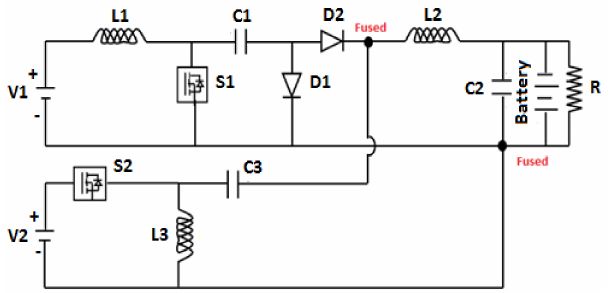
Figure 3. Circuit topology with the Cuk-Luo integrated converter.